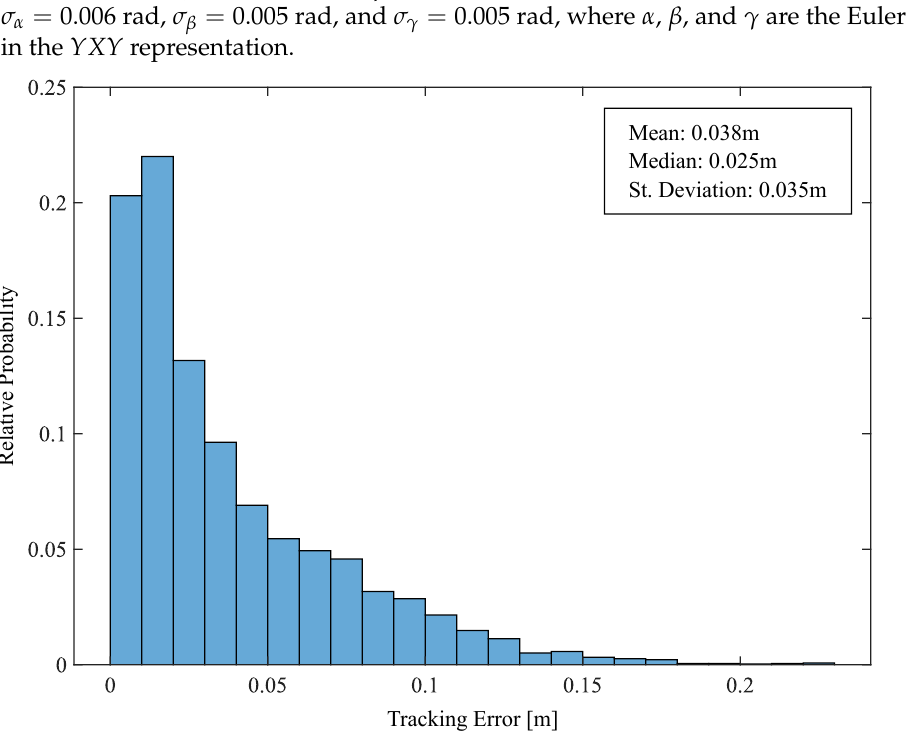
Figure 14. Histogram of the norm of the tracking error. The vertical axis indicates the relative probability of each histogram